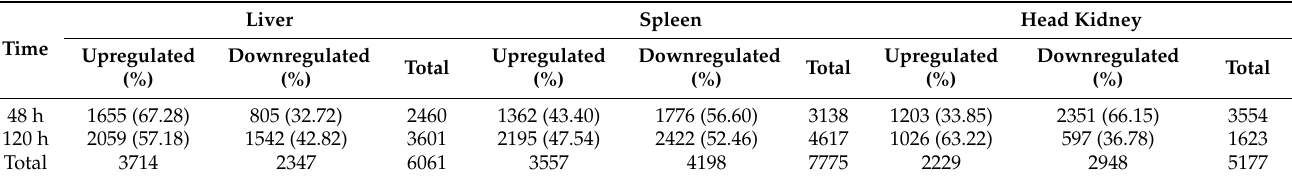
Table 2. Statistics of differentially expressed genes at different time points following S. agalactiae challenge.